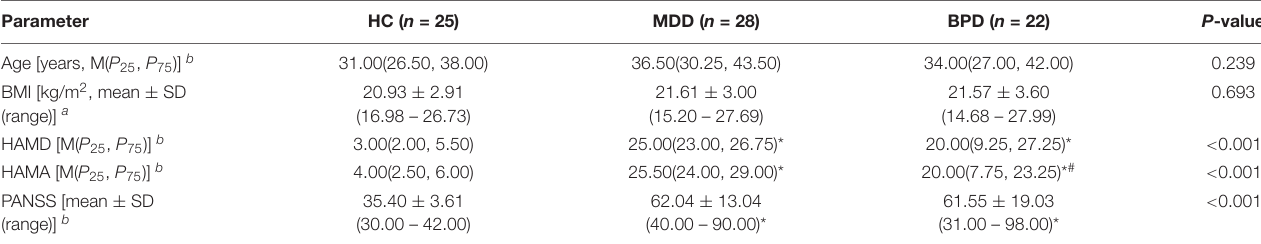
TABLE 1 | Comparison of clinical characteristics data and symptom scale assessment among the three groups.